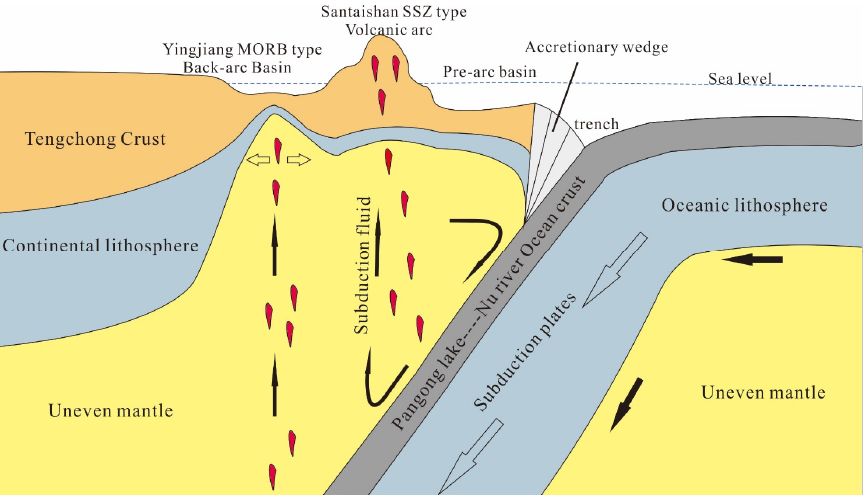
Figure 12. Tectonic setting model diagram of ultrabasic rock formation in Santaishan and Yingjiang.